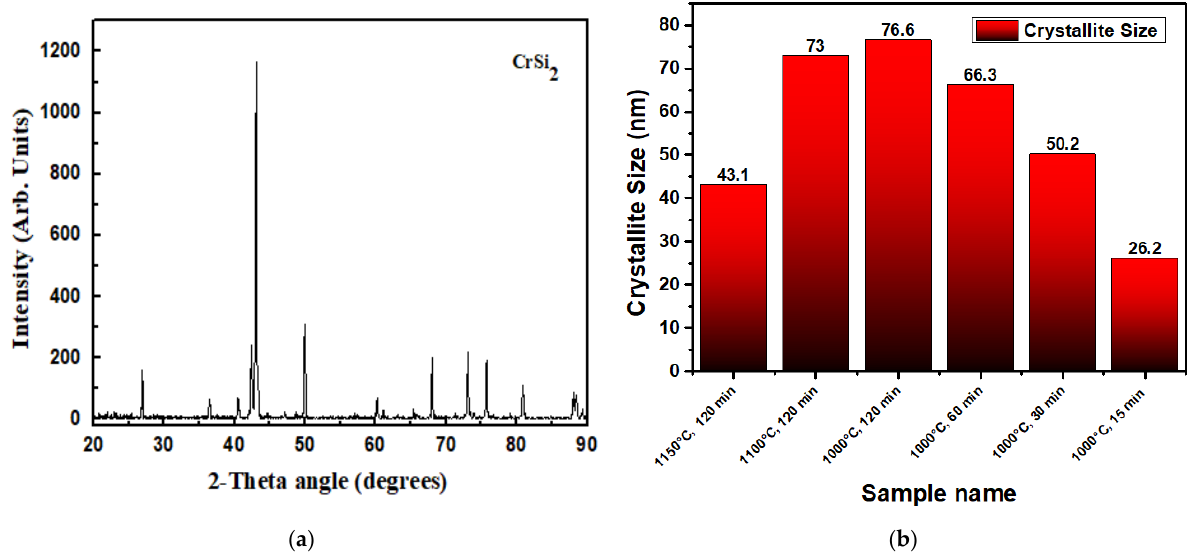
Figure 10. ( a ) XRD pattern of the siliconized samples; ( b ) crystallite size calculated by the WH analysis. The peaks were indexed by use of PDF #35-0781 (CrSi 2 ) [34]. Table 4. Calculated parameters from the synthesis of CrSi 2 samples at various temperatures and times.